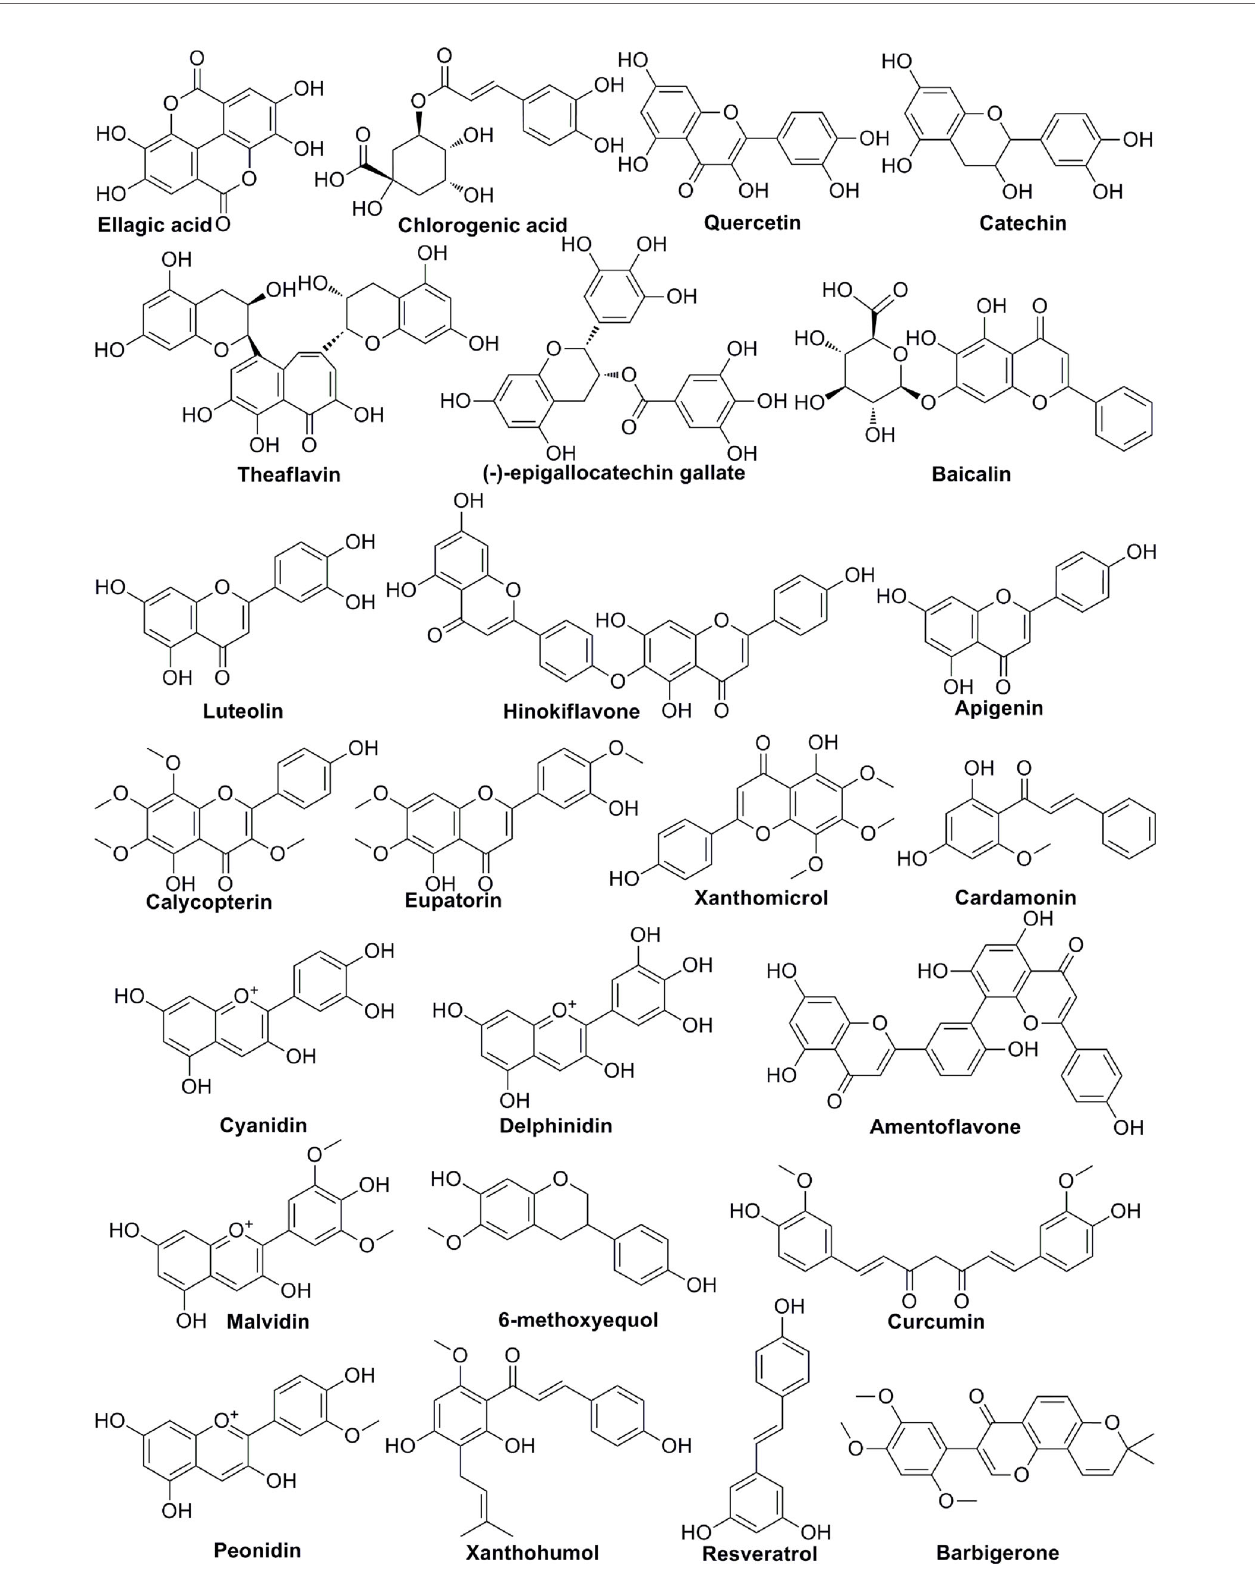
FIGURE 3 | The chemical structures of polyphenols involved in tumor